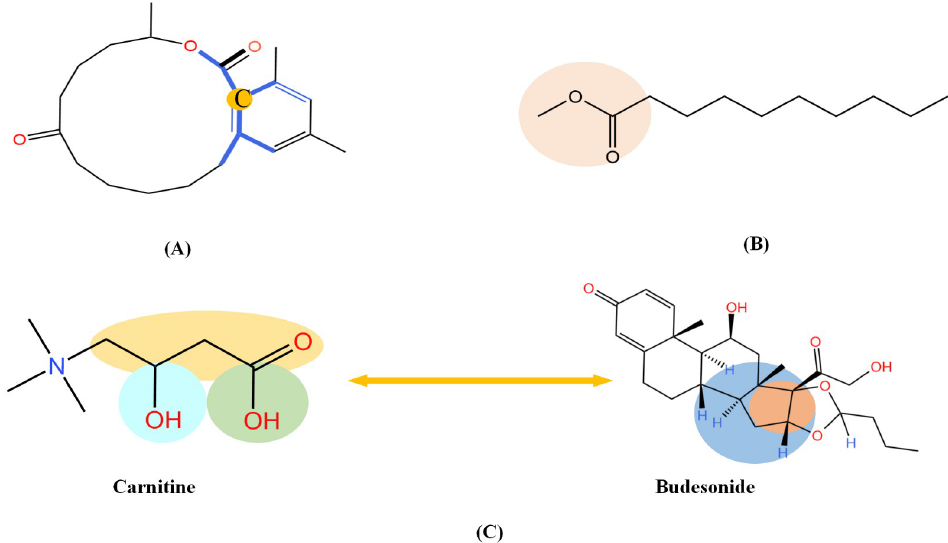
Fig 14. Both structure information and DDIs are important for GNN. (A) The sight of GNNs in the second layer is shown in blue as we take the carbon with orange as the center. In this example, a GNN with two layers fails to identify the ring structure of zearalenone. (B) The GNN should preserve local structure information (orange ellipse) (C) The interaction type of ‘blood calcium increased’ between drug pair ‘Carnitine’ and ‘Budesonide’ is caused by their partial significant substructures (elliptical